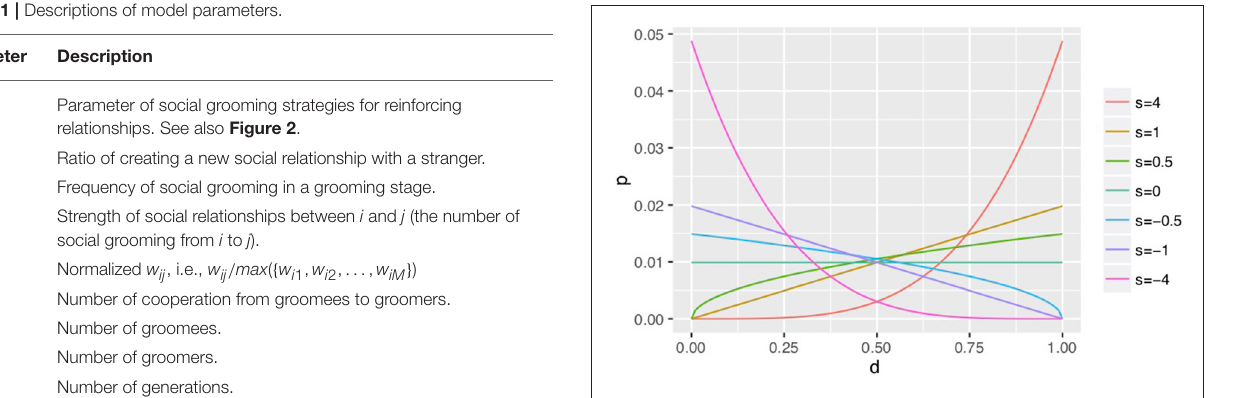
FIGURE 2 | Examples of social grooming strategies. Social groomers with large s tend to interact with a groomee in a strong social relationship (large d ). On the other hand, groomers with small s tend to interact with a groomee in a weak social relationship (small d ). When s = 0, groomers interaction is independent from d . When s = 1, groomers interact in proportion to the strength of social relationships, i.e., the Yule–Simon process.